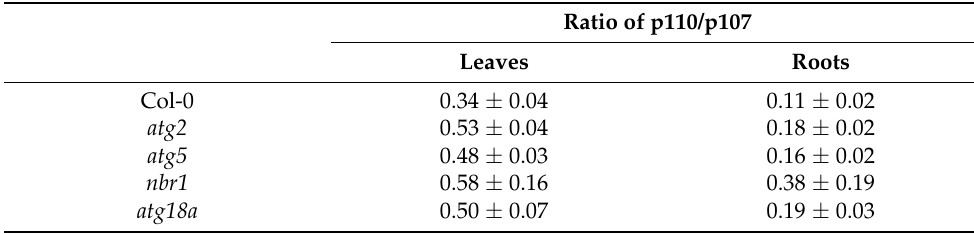
Leaves or roots from six-week-old Arabidopsis Col-0, atg2, atg5, nbr1, and atg18a SALK lines were pooled (30 plants for sample). Proteins aliquots from crude extracts from leaf or roots were analyzed by SDS-PAGE and immunoblotted with anti-PEPC antibodies. The ratios (Ub-PEPC/PEPC) of the signals were calculated. The table shows quantitative data (mean ± SE, n = 5) for the